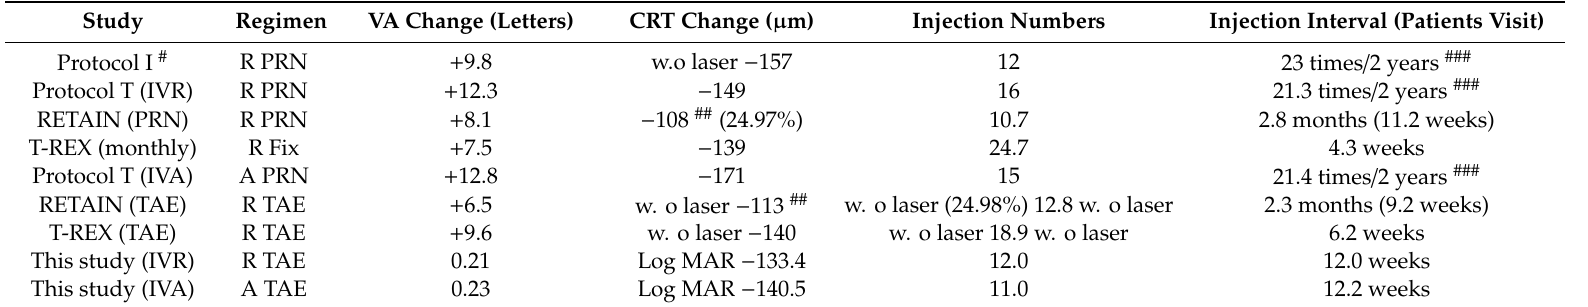
Table 4. Comparisons of various DME treatment